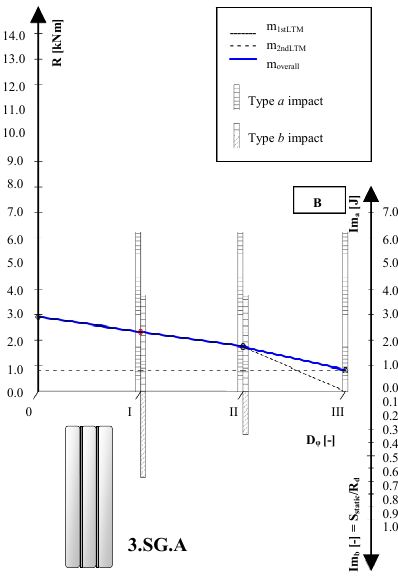
Figure 12: Element Safety Diagram for triple layer, SG-laminated, annealed glass beam.